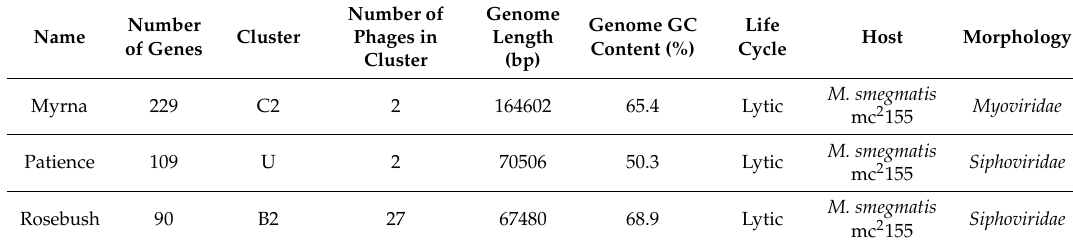
Table 1. Basic information about the three actinobacteriophages Myrna, Patience and